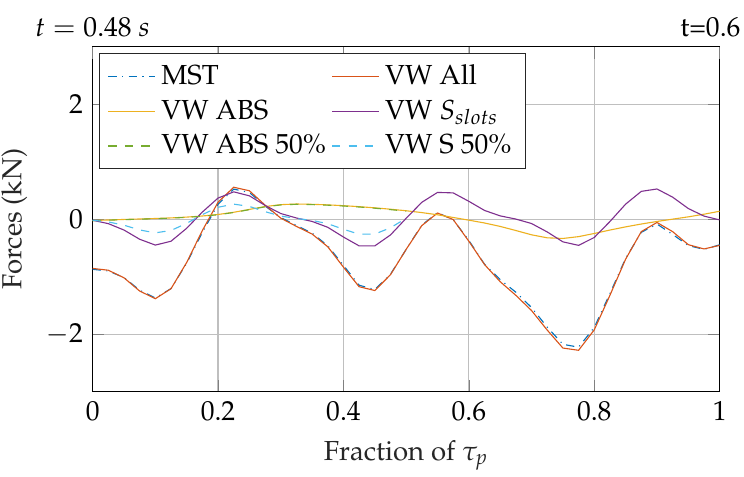
Figure 1. The total detent force calculated with Maxwell stress tensor (MST) and virtual work (VW) for one pole pitch τ p , starting at t = 0.48 s and ending at t = 0.6 s. The contribution of VW from all domains (VW All), above and below stator (ABS), and in the stator slots ( S slots ) are plotted.